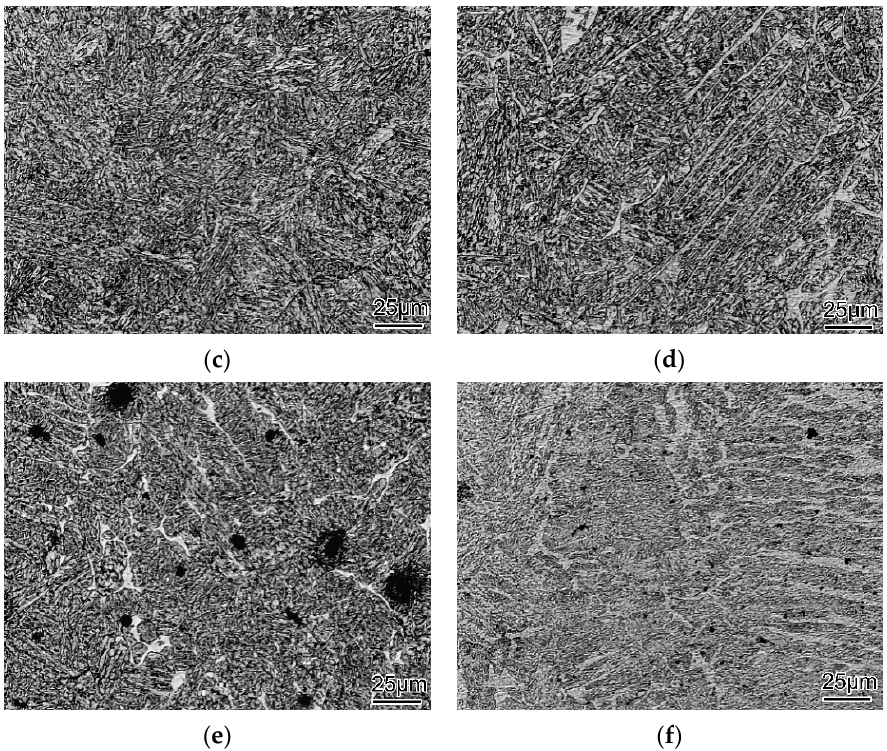
Figure 5. Effect of Al content on microstructure morphology of weld metal: ( a ) 0% Al; ( b ) 0.21% Al; ( c ) 0.38% Al; ( d ) 0.62% Al; ( e ) 0.81% Al; ( f ) 1.05% Al.